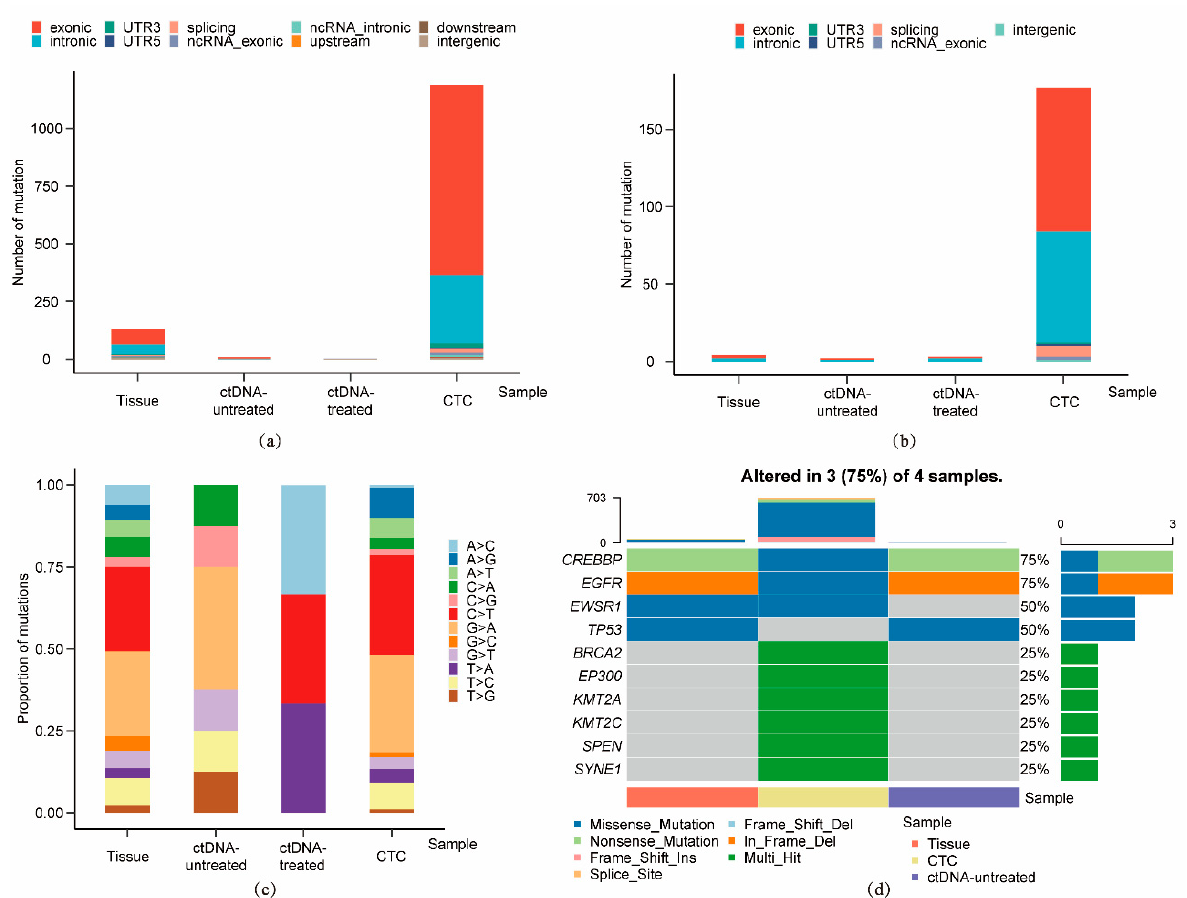
Figure 5. The genetic variations of liver biopsy tissue, ctDNA and single CTC samples. ( a ) The distribution of SNVs on the genome. ( b ) The distribution of InDels on the genome. ( c ) The proportion of different base mutation types. ( d ) The top 10 somatic mutations among 4 samples.